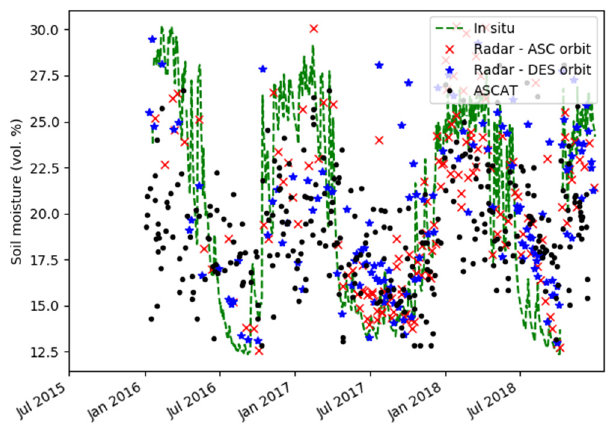
Figure 10. Comparison of surface soil moisture from SMES and ASCAT products, ground measurements, over the MTM site (France).